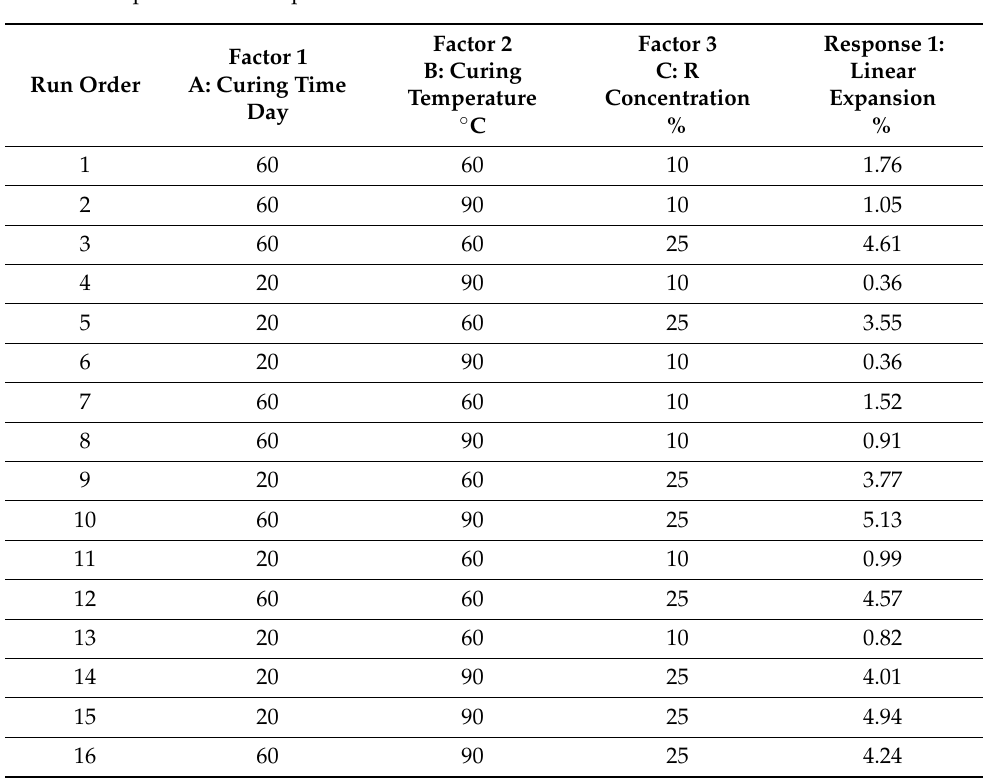
Table 5. The pilot runs for